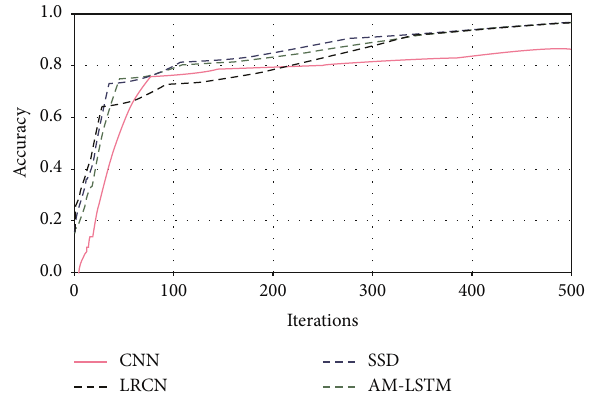
Figure 14: Accuracy curve of four